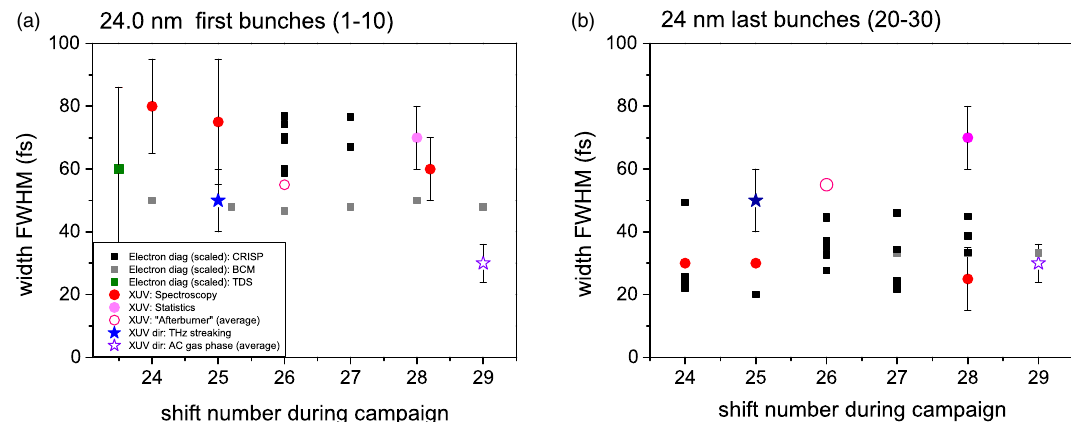
FIG. 16. XUV and electron bunch duration (FWHM) measurements during the 24 nm run. (a) shows the pulse durations for the first bunches (1 – 10) in the bunch train; (b) shows the pulse durations for the last bunches (20 – 30). The electron bunch duration is scaled by a factor of 0.66 to match the average electron pulse duration to the photon pulses. Electron pulse measurements are indicated by a rectangular symbol, indirect photon pulse duration measurements by circles, and direct XUV measurements by stars. Furthermore, the pulse-resolved methods are plotted with solid symbols, while the averaging techniques are shown as open symbols. The horizontal axis indicates the shift number during the campaign. A shift corresponds to 8